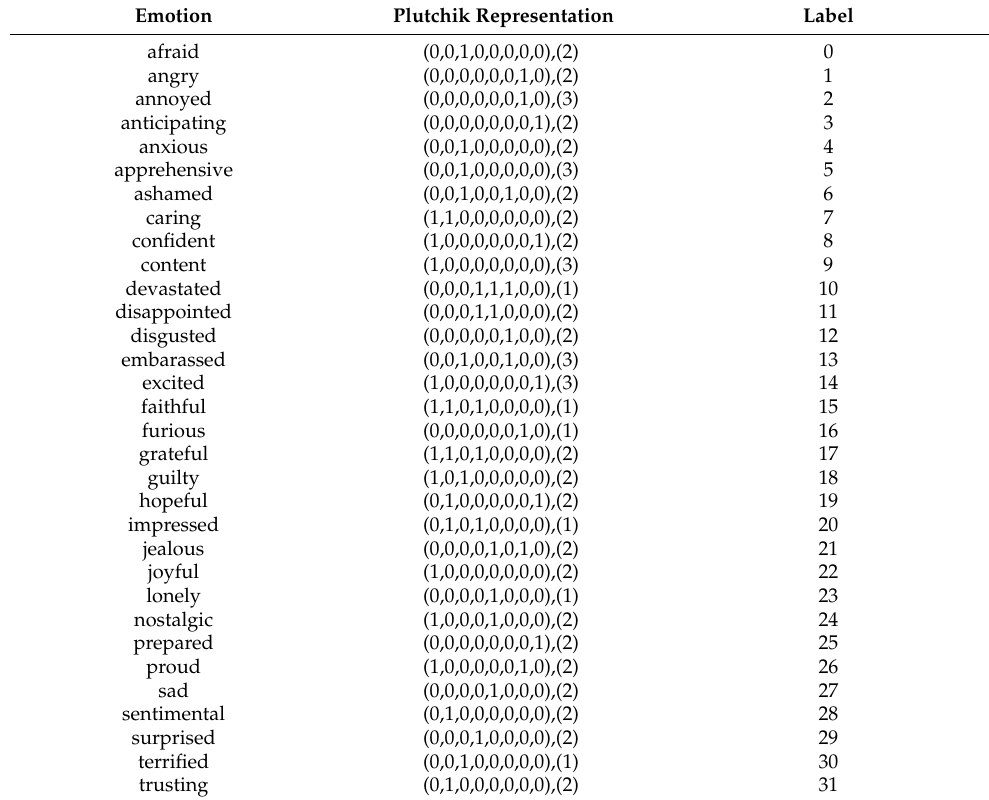
Table A1. Emotional context